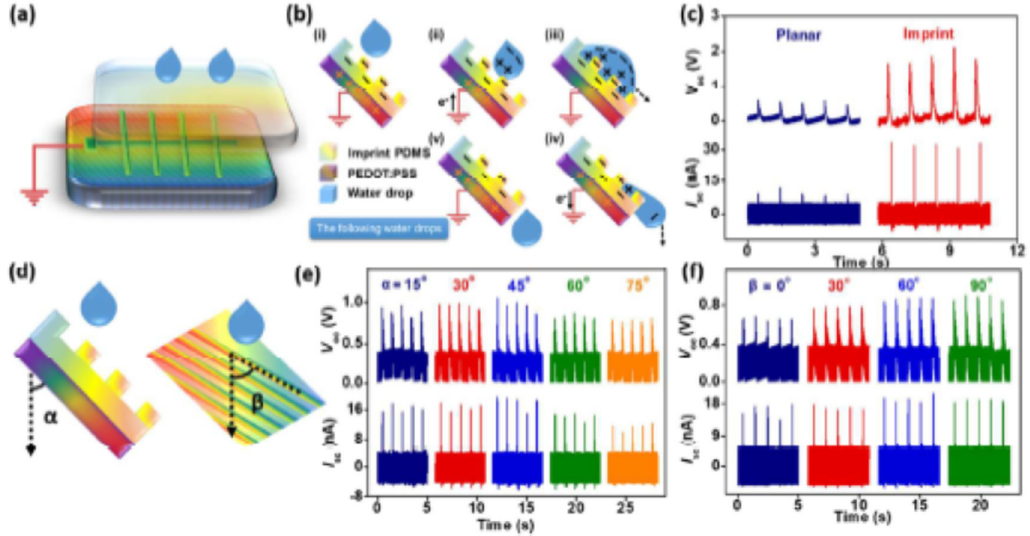
Figure 10. TENG device structure and general performance of TENG for harvesting mechanical energy from water drops. ( a ) Schematic illustration of a typical TENG structure; ( b ) Working mechanism of TENG; ( c ) V ocTENG and J sc outputs of TENG with or without surface imprint; ( d ) Schematic illustration of angle α between water dripping direction and the device, and the angle β between water dripping direction and imprinted structure; ( e ) V ocTENG and J sc outputs of TENG under different α ; ( f ) V ocTENG and J sc outputs of TENG under different β . Reproduced with permission from [36] Copyright © 2021, American Chemical